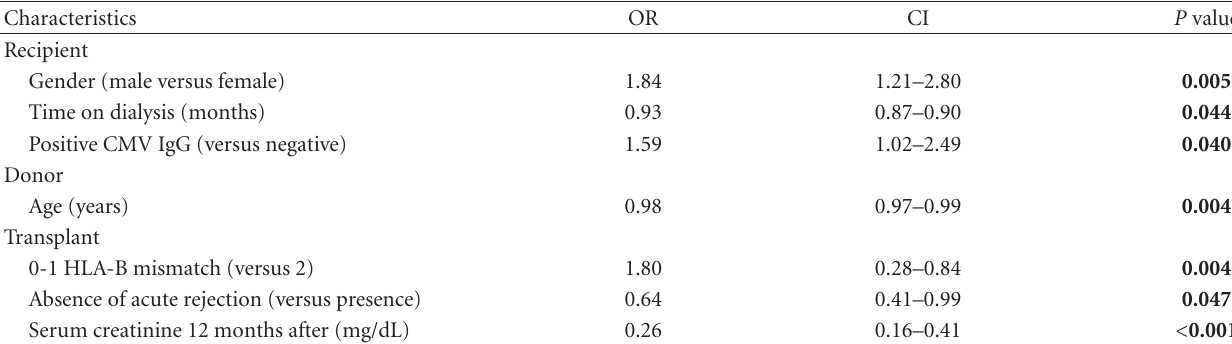
Table 3: Long-term graft survival predictors; multivariate-adjusted logistic